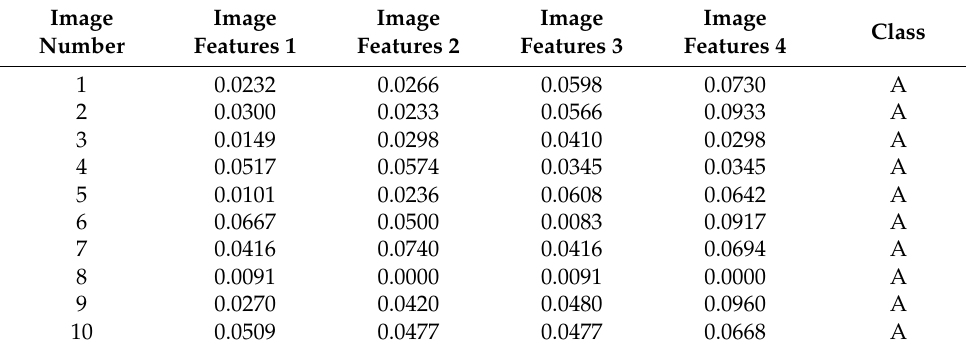
Table 2. Part of the feature table used by the classification